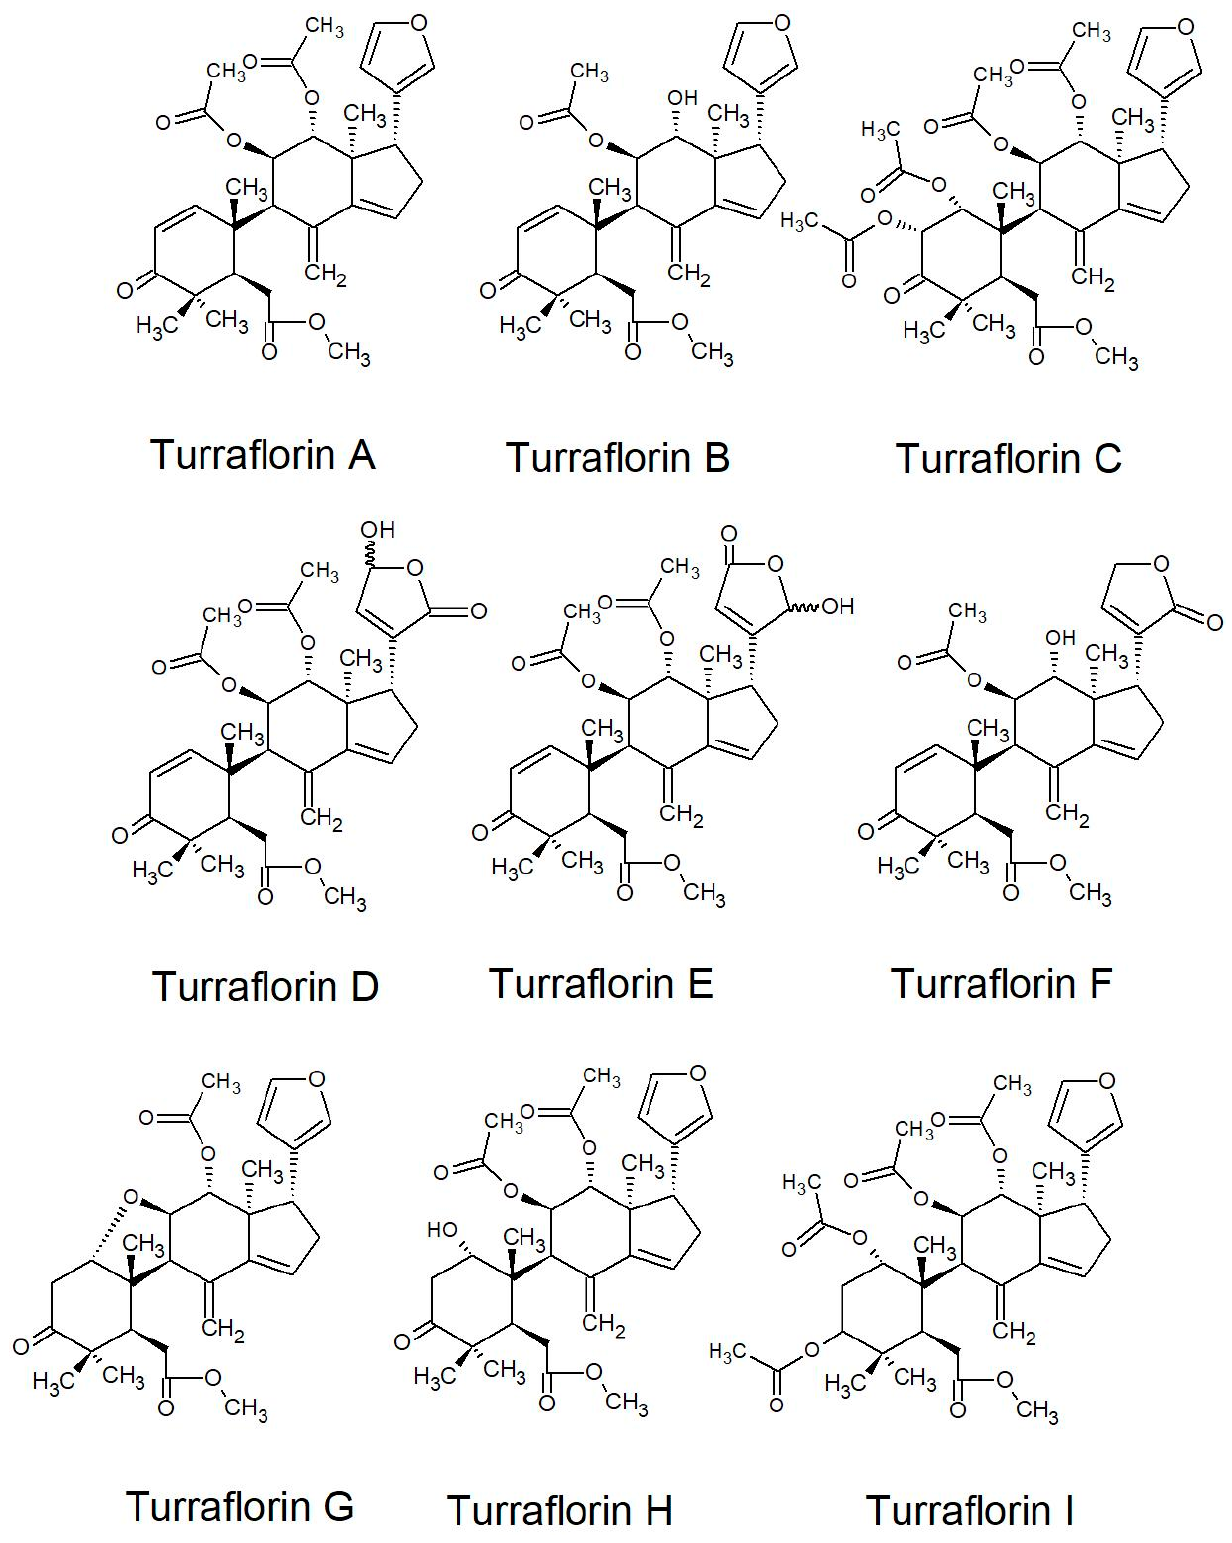
Figure 16. Turraflorin series of limonoids reported from South African Meliaceae [112,144].